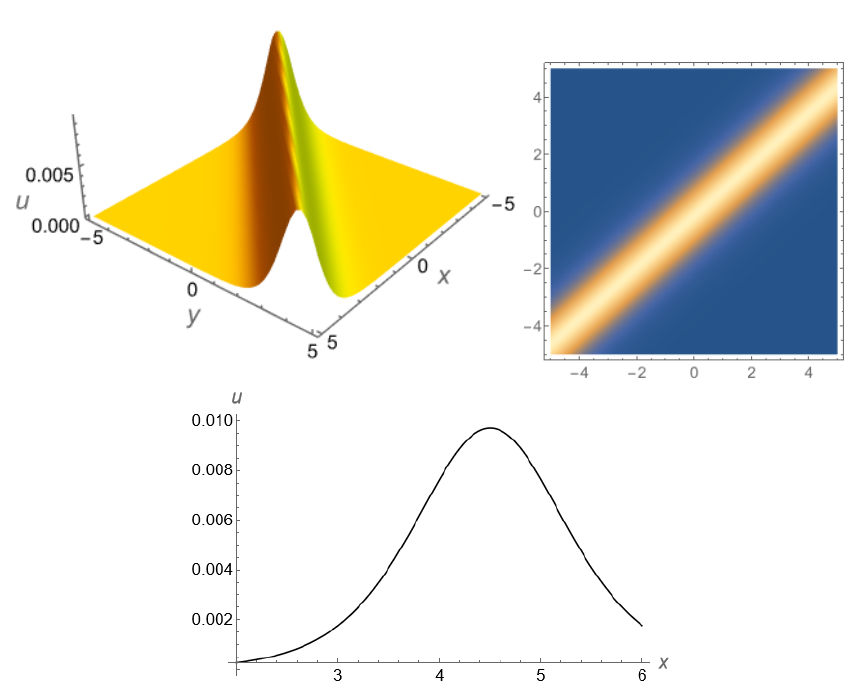
Figure 2. The 3D and 2D solution profiles of (27).